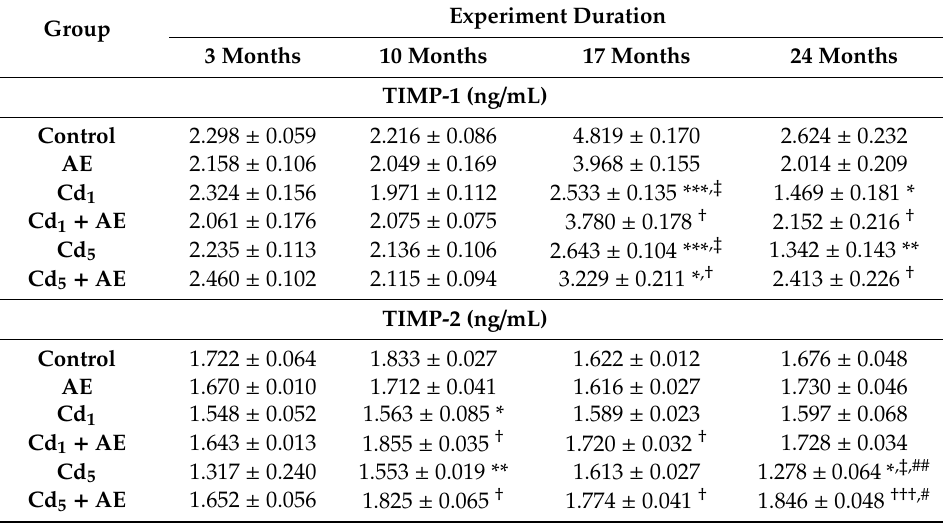
Table 5. The e ff ect of Aronia melanocarpa L. berry extract (AE) on the concentrations of tissue metalloproteinase inhibitor-1 (TIMP-1) and tissue metalloproteinase inhibitor-2 (TIMP-2) in the serum of rats treated with cadmium (Cd) 1,2 .